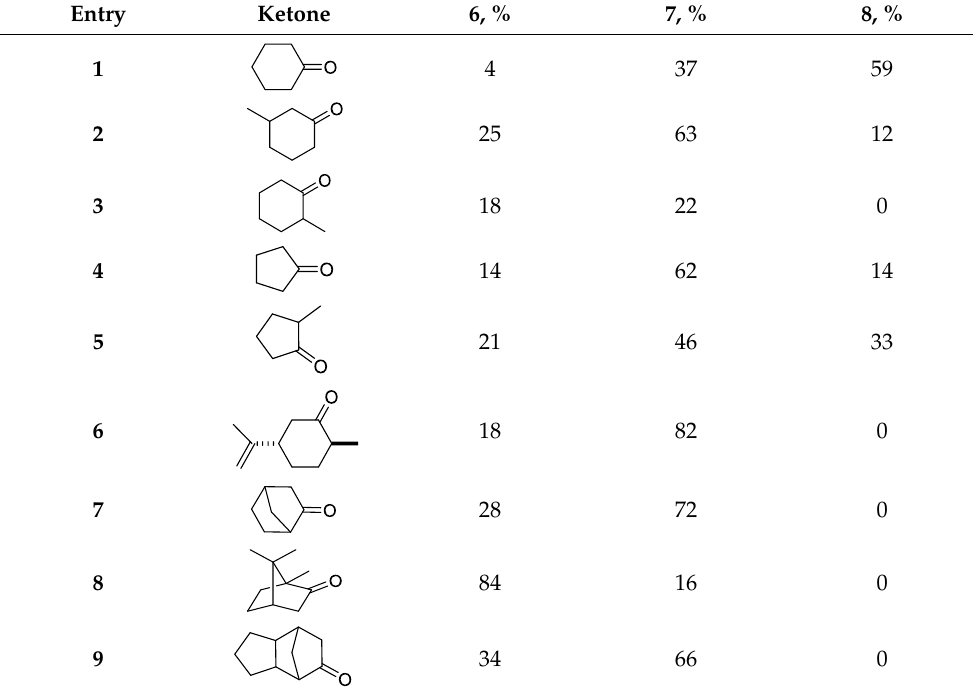
Table 1. The proportion of the products in the reaction mixture after the reaction of a cyclic ketone with acetonine according to gas chromatography–mass spectrometry (GS–MS) analysis*. Entry